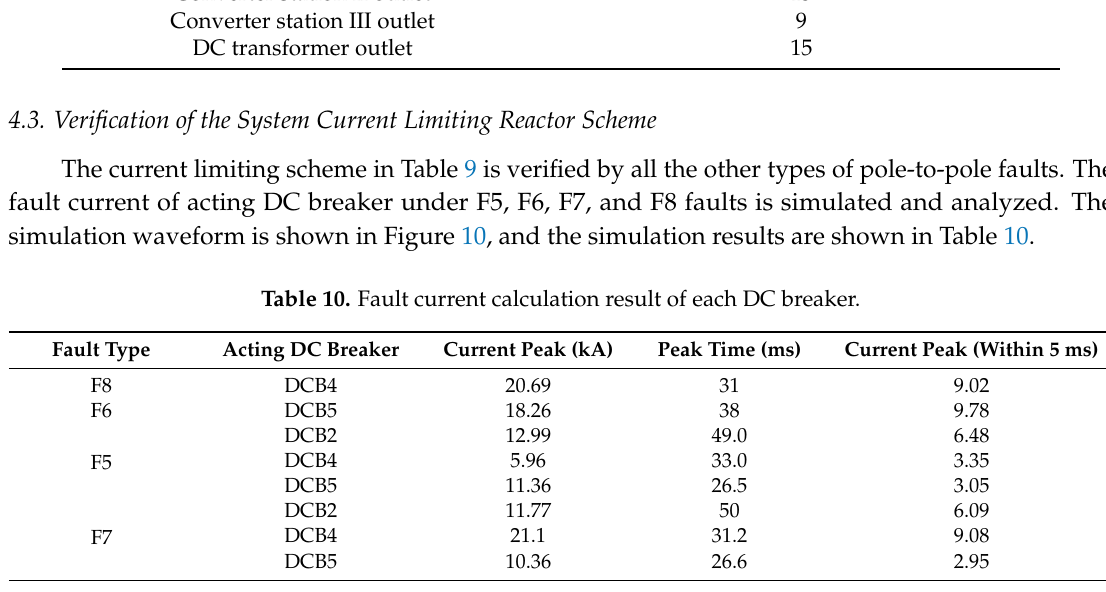
Table 10. Fault current calculation result of each DC breaker.